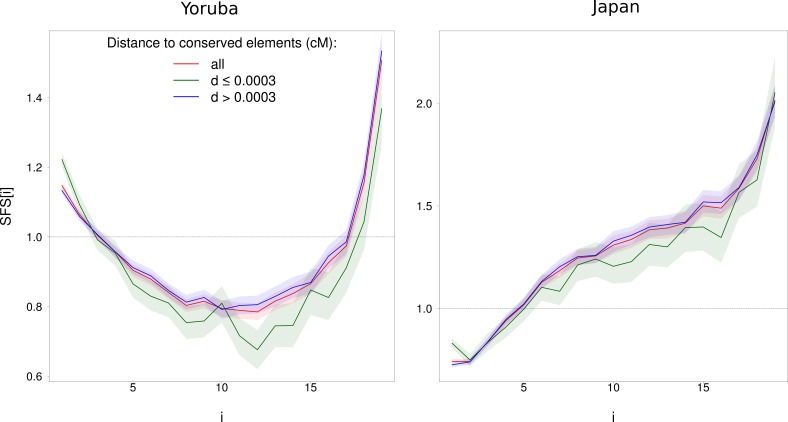
Impact of physical distance to phastCons conserved elements on the normalized SFS for WW + SS sites with RR ≥ 1.5 cM/Mb (in red) on Yoruba (left) and Japan (right) populations.Sites that are less (resp. more) than 0.0003 cM from conserved elements are in green (resp. in blue). phastCons elements are defined in the Materials and methods section. The SFS of sites with d > 0.0003 cM is not different from all sites for both populations while the SFS of sites with d ≤ 0.0003 cM is (p<10−3). Shaded areas correspond to 95% CI obtained by a block-bootstrap approach (see Materials and methods).